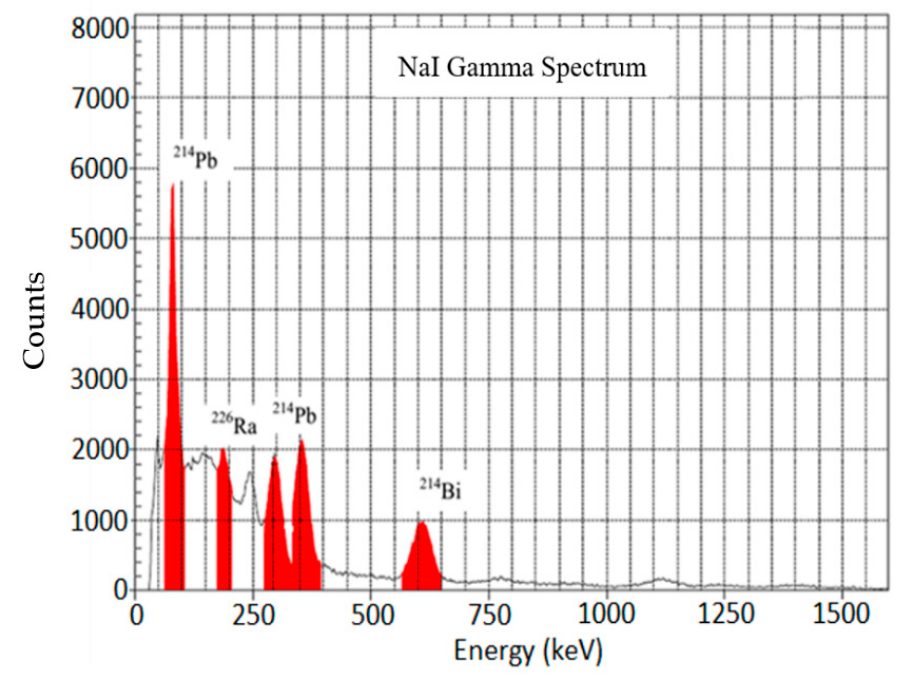
Figure 3. The Canberra InSpector 1000 NaI gamma spectrum of the site ID1, as an example.